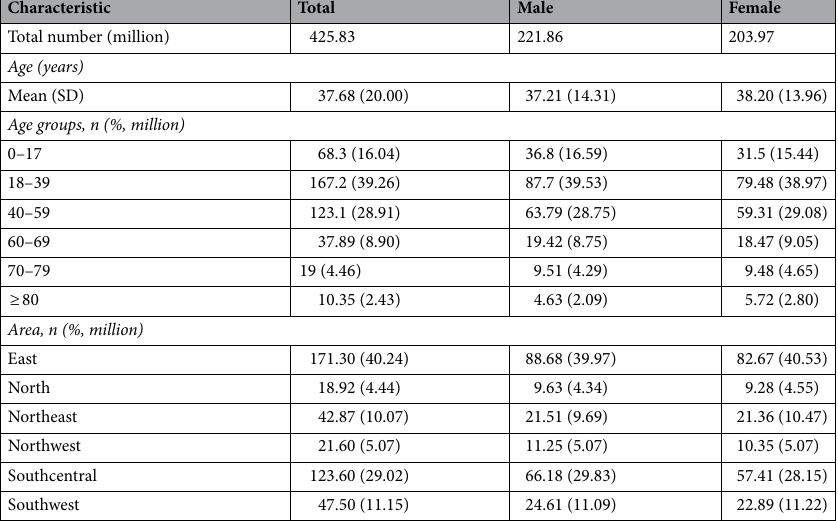
Table 1. Characteristics of the urban population from 23 provinces in China in 2016. SD, standard deviation. Note: East area contains Jiangsu, Zhejiang, Anhui, Jiangxi, and Shandong (five provinces). North area contains Shanxi, Inner Mongolia (two provinces). Northeast contains Liaoning, Jilin, Heilongjiang (three provinces). Northwest contains Shaanxi, Qinghai, Gansu, and Xinjiang (four provinces). Southcentral contains Henan, Hubei, Hunan, Guangdong, Guangxi and Hainan (six provinces). Southwest contains Chongqing, Guizhou and Yunnan (three provinces).